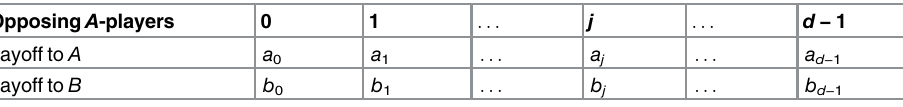
Table 1. Payoffs to A -players and B -players. Opposing A